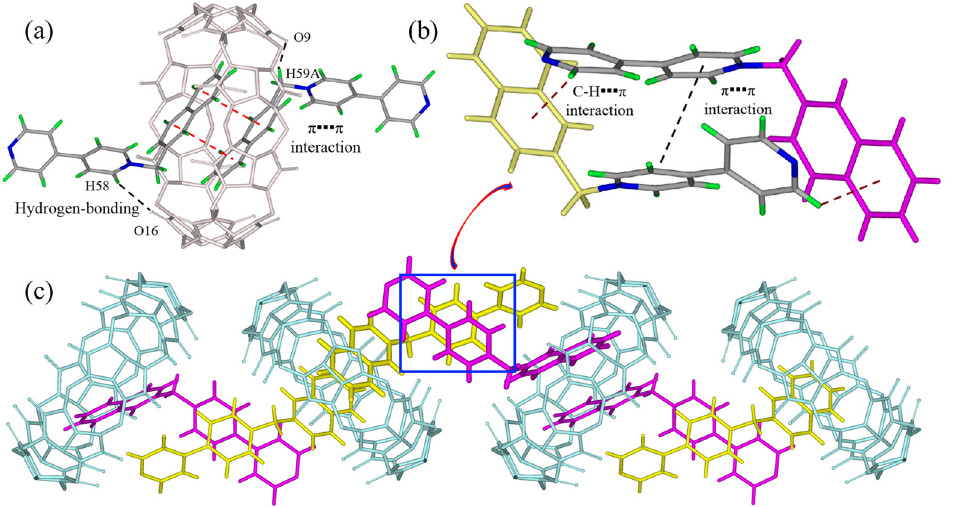
Figure 6. ( a ) X-ray crystal structure of the homoternary complex Nap1 2 @Q[8]. Solvate water molecules and [CdCl 4 ] 2 − anions were omitted for clarity. ( b ) The C–H··· π interaction and π ··· π interaction between two neighboring Nap1 molecules. ( c ) Crystal structure of a one-dimensional supramolecular chain constructed of the Nap1 and Q[8].